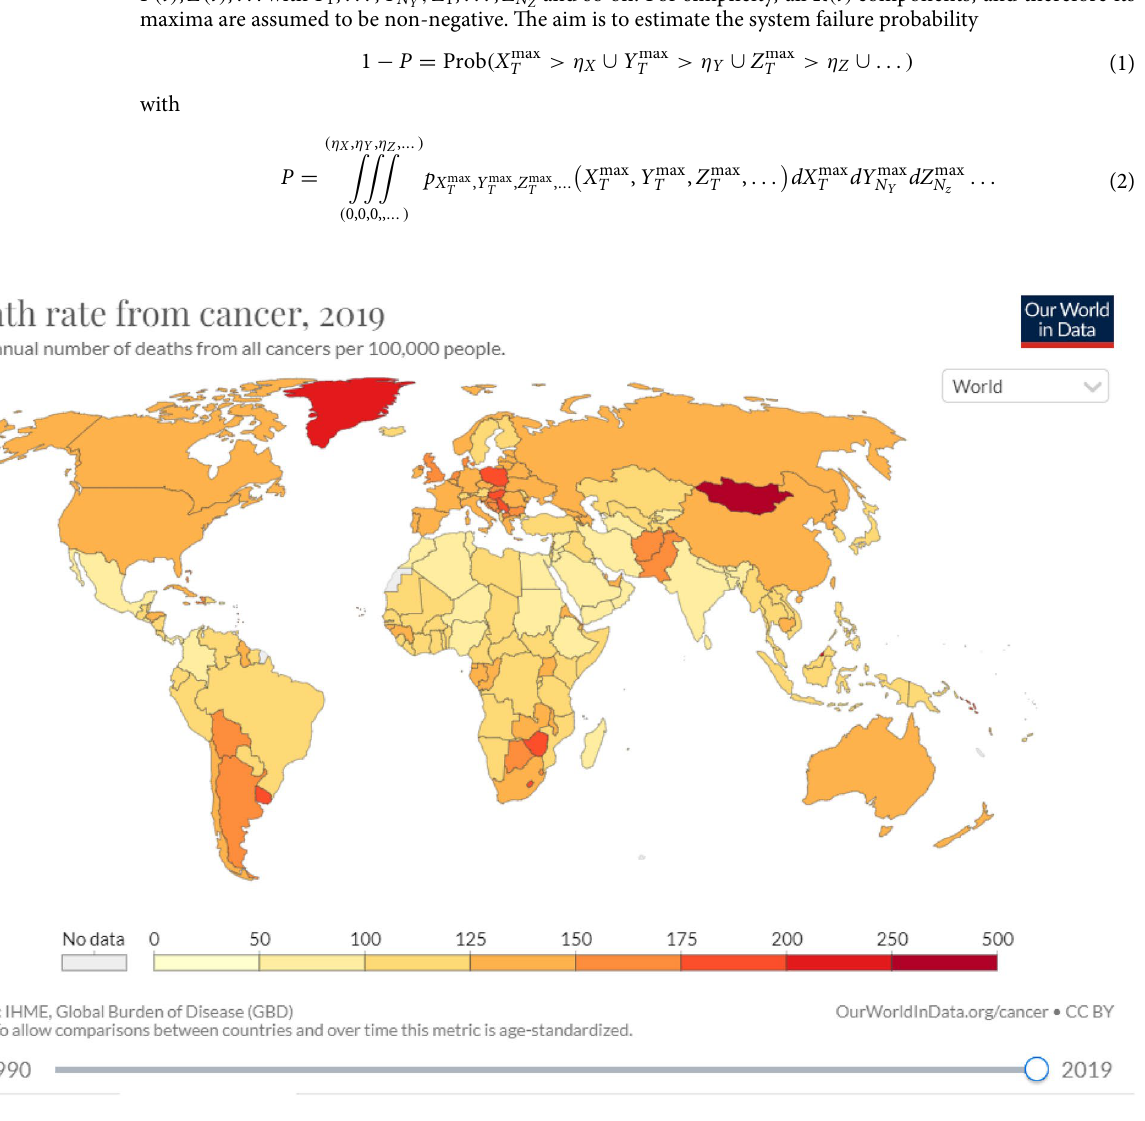
Figure 1. Map of the world with countries and cancer deaths. All world countries were studied in this paper 1